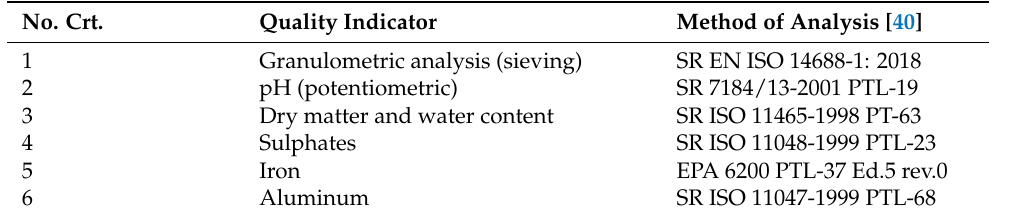
Table 1. Methods used for soil quality indicators. No.